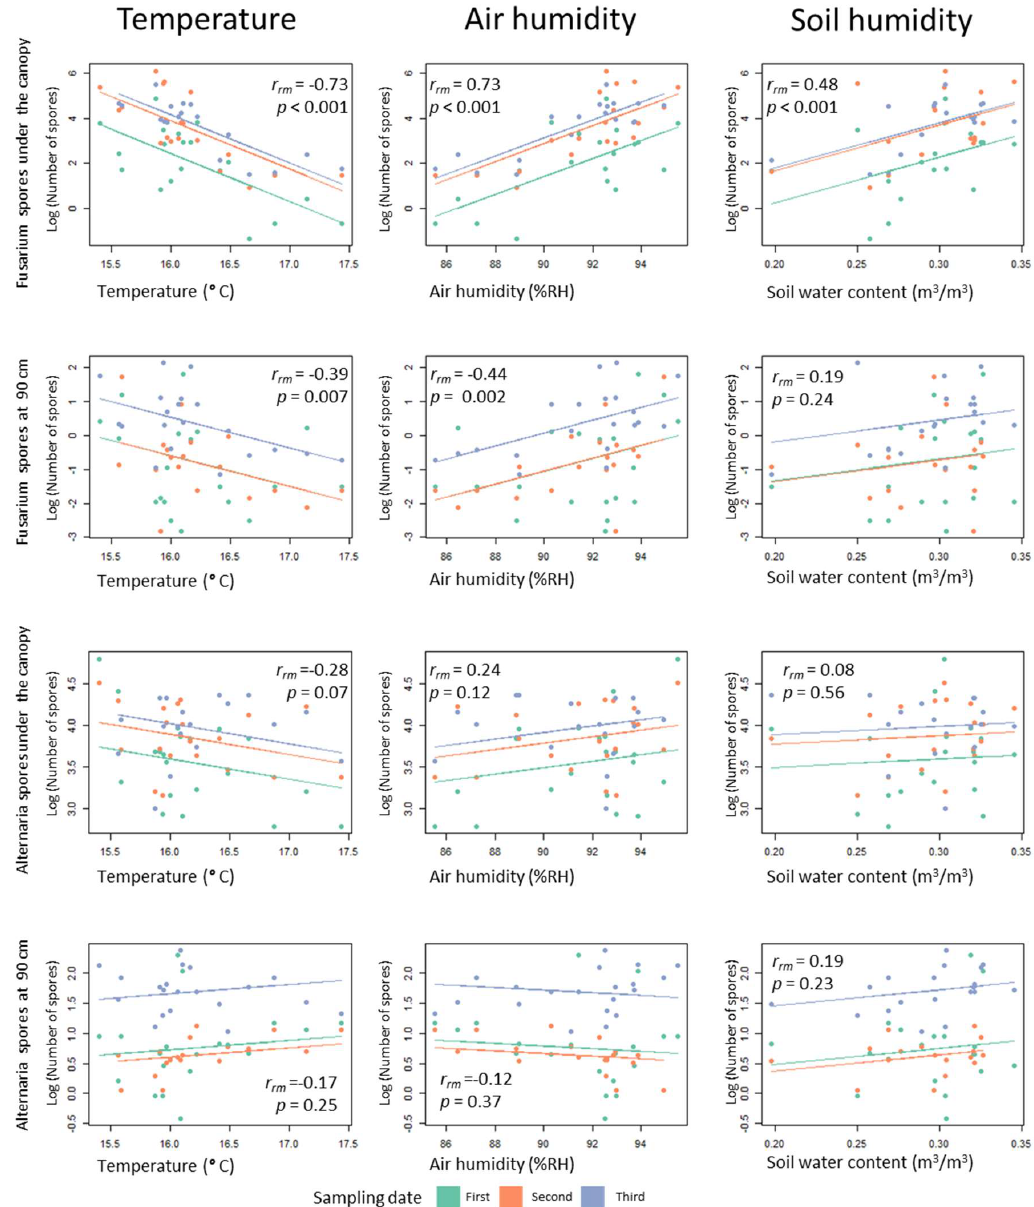
Figure 6. Correlation matrix between environmental parameters and number of spores counted of Fusarium and Alternaria fungi. The three sampling dates are represented in different colours. The lines show rmcorr fits for each sampling date. These are the best linear fits for each sampling date with the same slope but different intercepts. The rmcorr coefficient ( r rm ) shows the strength of the linear association between the two variables. Like a Pearson correlation coefficient, it is a value between +1 and − 1. p -values are corrected for multiple comparisons using an FDR